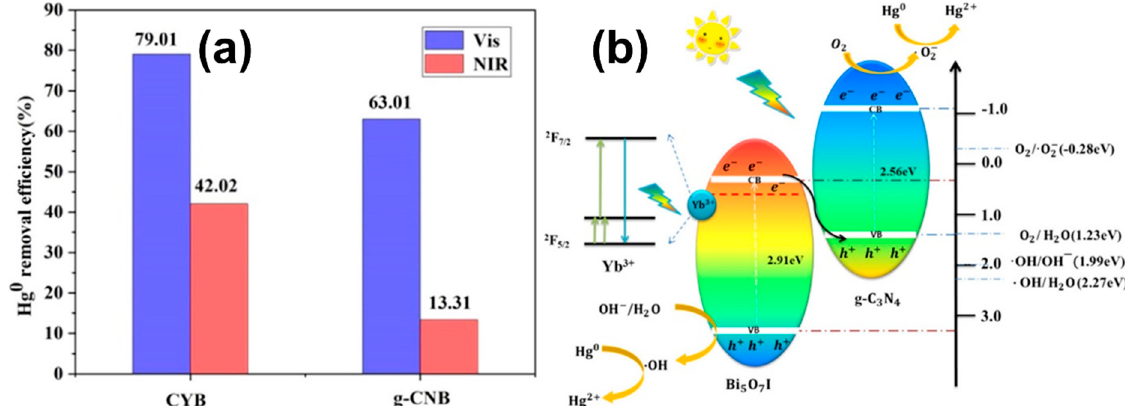
Figure 6. ( a ) Mercury removal efficiency under visible and near infrared light excitation in the presence of g-C 3 N 4 /Yb 3+ - Bi 5 O 7 I (CYB) and g-C 3 N 4 -Bi 5 O 7 I (g-CNB) as photocatalysts, ( b ) schematic depicting the mechanism of charge transfer in the Z-scheme heterojunction g-C 3 N 4 /Yb 3+ -Bi 5 O 7 I during the photocatalytic oxidation of Hg 0 . Reprinted from Ref. [108] with permission from American Chemical Society.